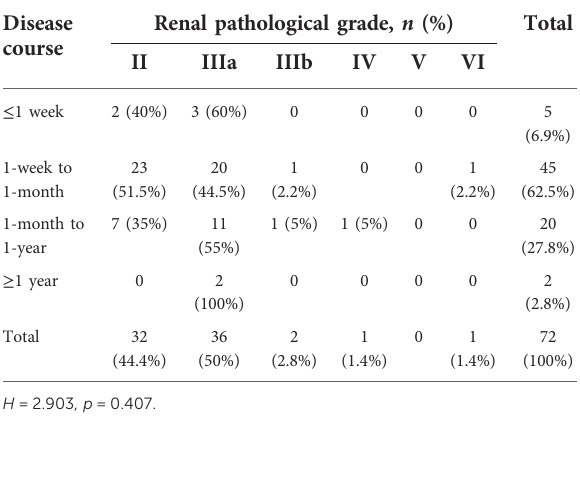
TABLE 3 Relationship between renal pathological grade and disease course.